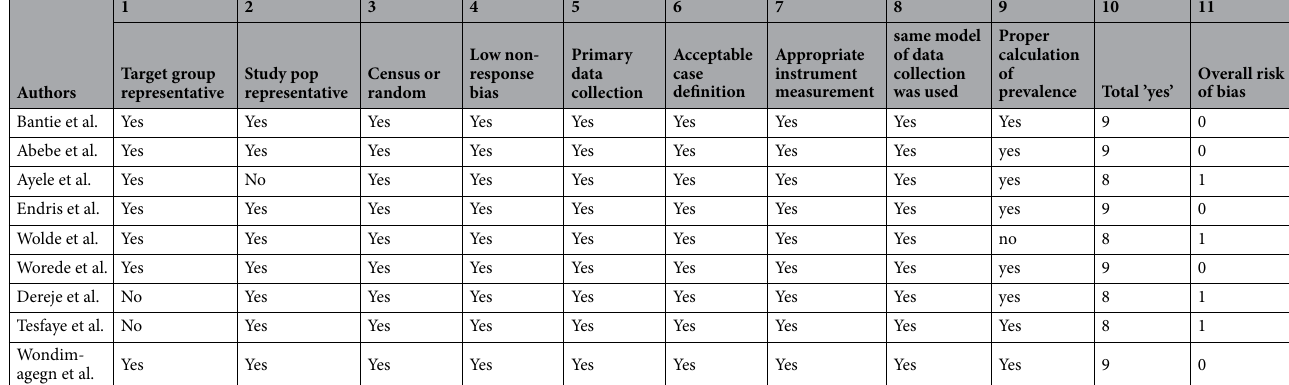
Table 1. Quality assessment of individual studies included in systematic review and meta-analysis on prevalence and associated factors of Undiagnosed DM in Ethiopia,